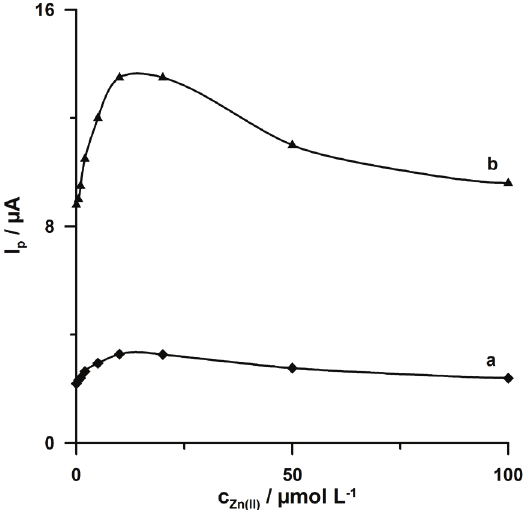
Figure 2: Influence of Zn(II) concentration on the voltammetric signal of Cd(II). The solution contained 0.1 mol L -1 acetate buffer pH = 4.6 ± 0.1, 5 × 10 -6 mol L -1 Pb(II), 5 × 10 -7 mol L -1 (a) or 2 × 10 -6 mol L -1 Cd(II) (b) and increasing concentration of Zn(II). Other parameters were as in Fig.